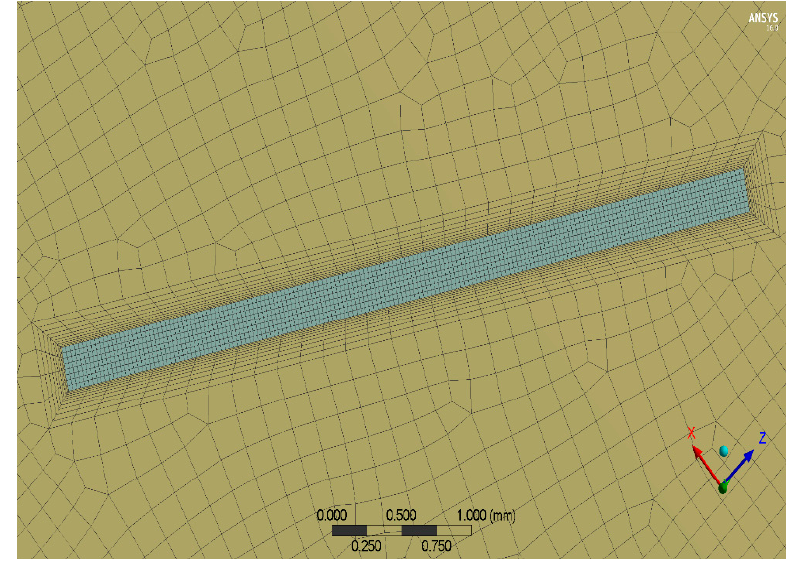
Figure 3. Close-up look for the grid near to the LVG refinement.